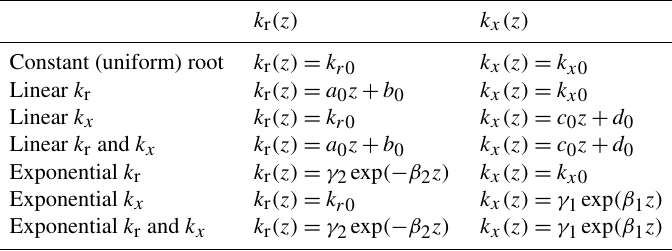
Table 1. Local hydraulic properties k r (z) and k x (z) for the different cases.